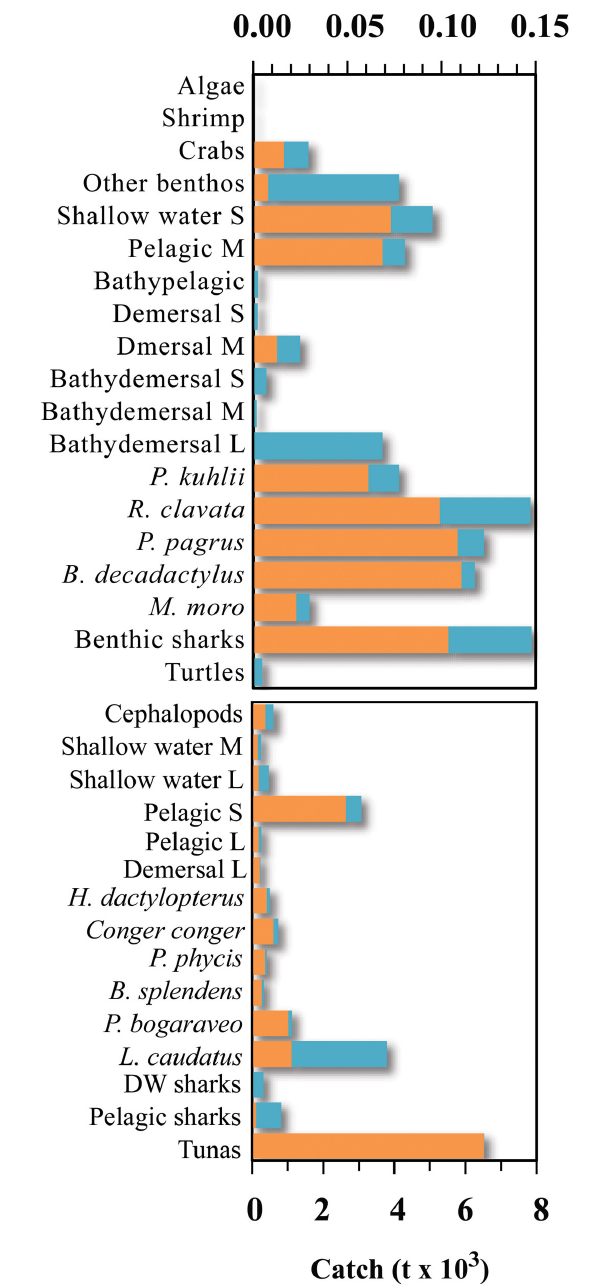
FIGURE 2 | Fisheries catch for the different groups included in the Azores ecosystem model, for the reference year 1997 (adapted from Pham et al., 2013). S, small-size; M, medium-size; L, large-size.